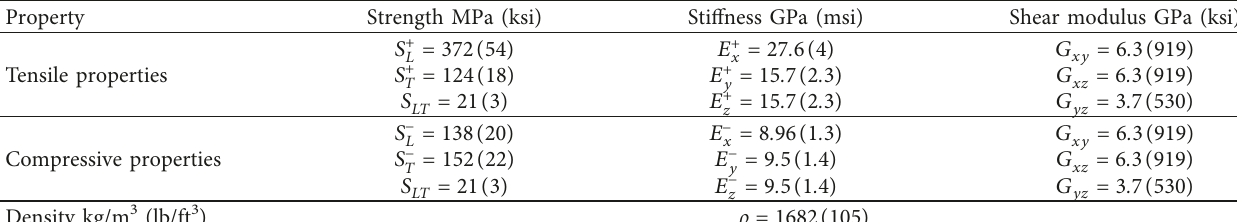
Table 1: Material properties used for modeling the FRP shell.